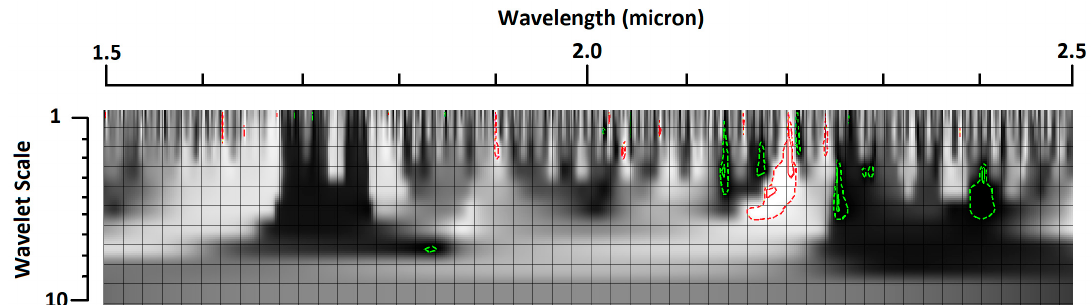
Figure 3. Scaleogram of the correlation coefficient Rfeature between ore processability and wavelet power for the 1.5~2.5 µm range. Red contours: Rfeature = 0.80 and 0.85; Green contours: Rfeature = − 0.80 and − 0.85.